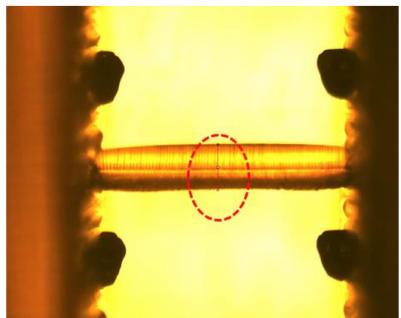
Figure A2. Use of ImageJ line tool to measure curing depth. The optical lens is focused on the notches to find optimal depth. Pixel length of line drawn at the center of the layer. Conversion is done to microns based on conversion